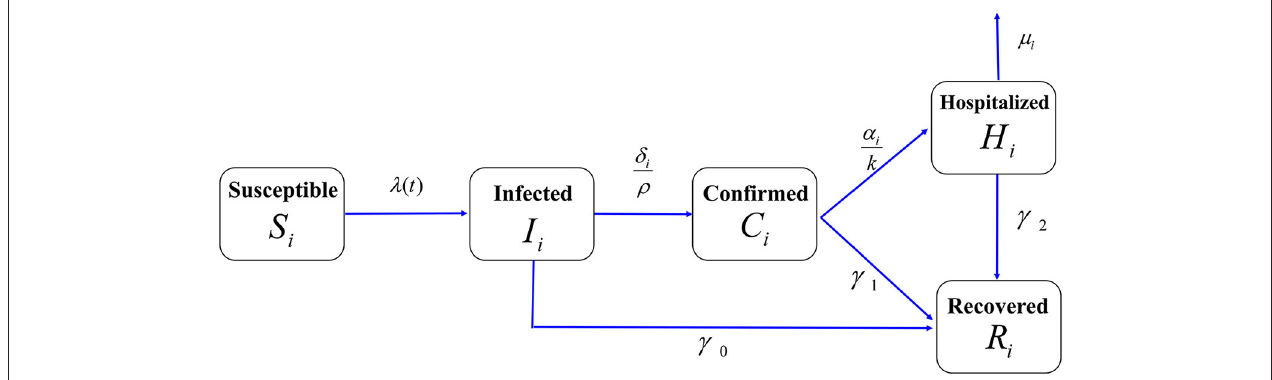
FIGURE 1 | Flow chart of the age-structured COVID-19 transmission model in NYC. The total population was divided into five compartments: Susceptible individuals ( S ), Infected individuals ( I ), Confirmed cases but stayed at home ( C ), Hospitalized cases ( H ), and Recovered cases ( R ). The population of each compartment was further divided into five age groups. We assumed that the confirmed cases that stay at home can cause household infection. The contact rate ( c ij ), death rate ( µ i ) , diagnosis rate ( δ i ) and hospitalization rate ( α i ) were assumed to be